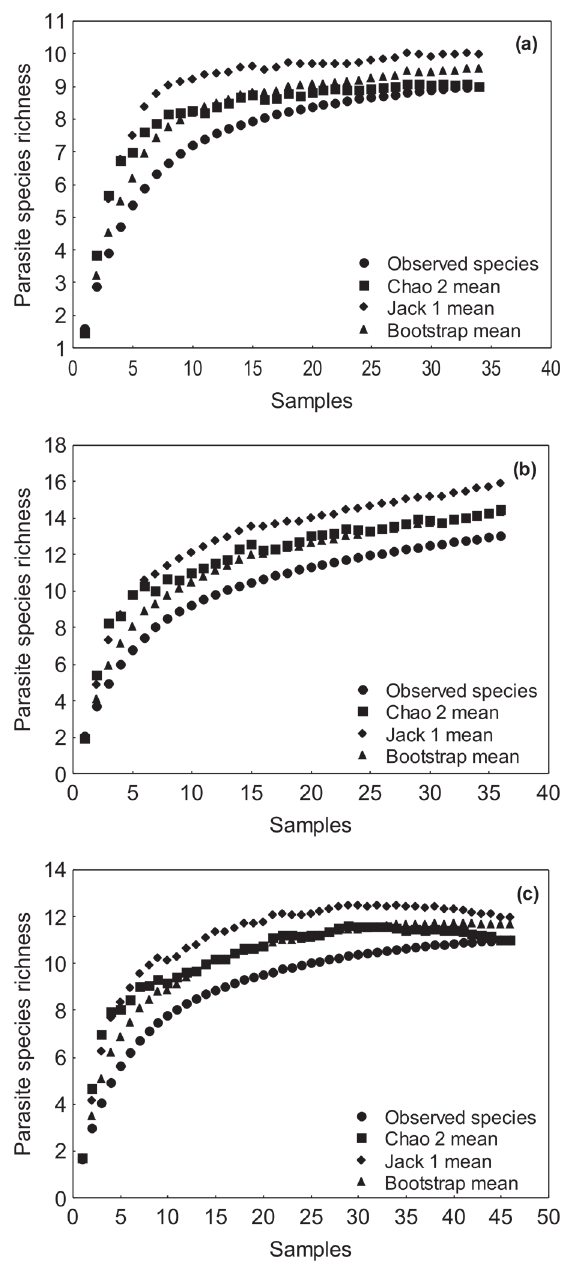
Figure 4 - Species accumulation curves of parasite component community for three populations of Leporinus friderici from upstream tributaries of Jurumirim reservoir, Upper Paranapanema River, southeast, Brazil. ( a ) Paranapanema, ( b ) Taquari, and ( c ) Veados